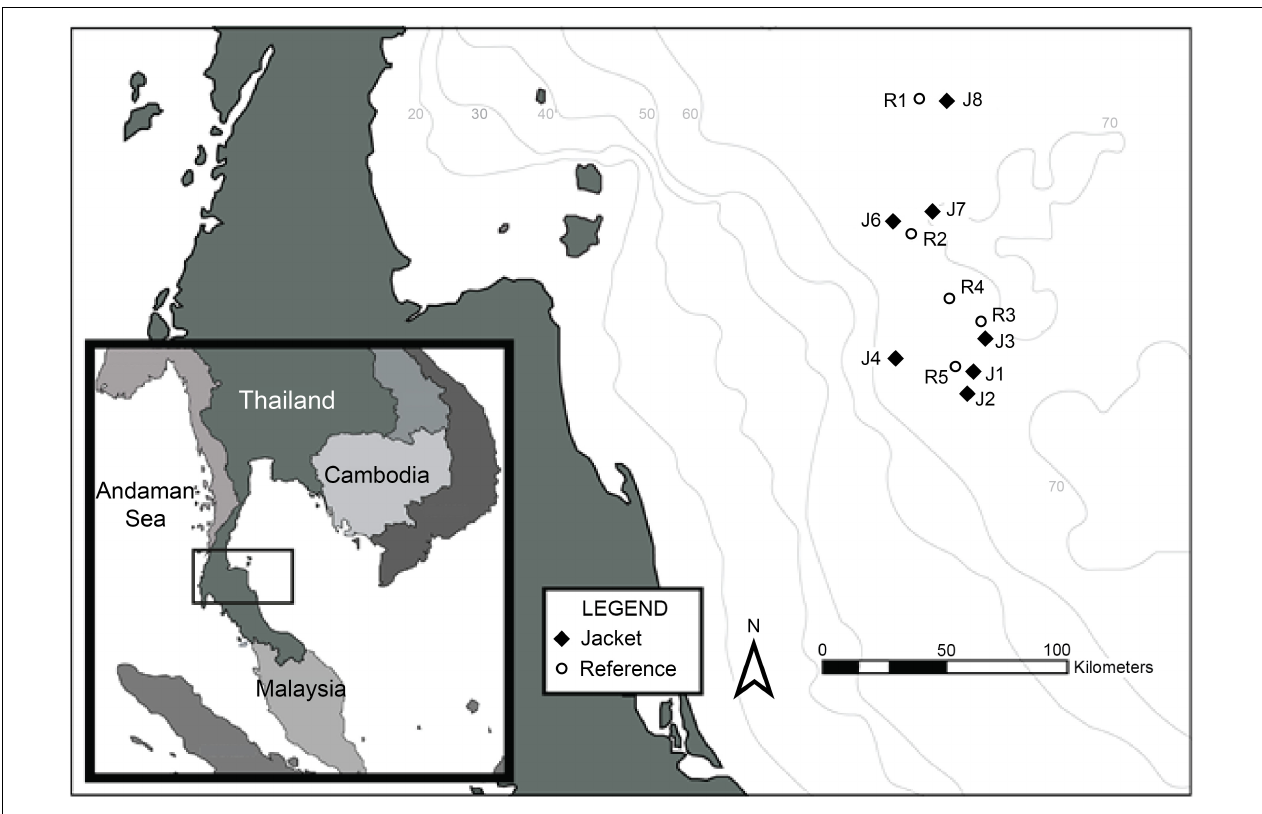
FIGURE 1 | Location of survey sites within the